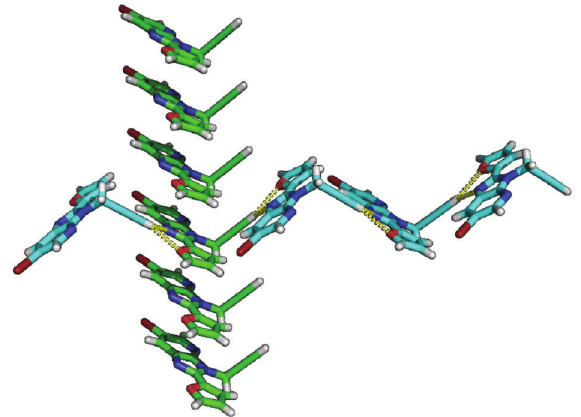
Figure 6: Arrays formed by 𝜋 - 𝜋 interactions (green colour) along the crystallographic 𝑎 -direction, and intermolecular C–H ⋅⋅⋅ N and C– H ⋅⋅⋅ O interactions (showed with yellow dotted lines) forming a zigzag structure (blue colour) along the 𝑏 direction.